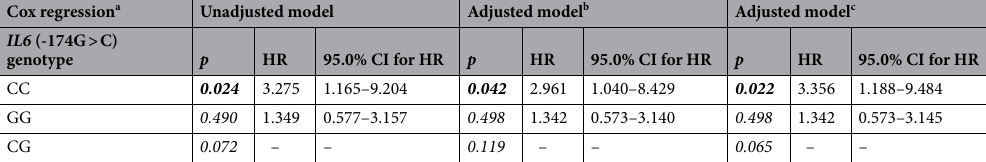
Table 8. Cox regression analysis according to the IL6 (rs1800795) polymorphism for all-cause mortality in end-stage renal disease patients ( n = 268). a Cox regression analysis using as reference the heterozygous genotype patients. b Adjusted for age, dialysis vintage and vascular access. c Adjusted for age, dialysis vintage, vascular access, and the co-morbidities, diabetes mellitus and history of cardiovascular disease. CI confidence interval, HR hazard ratio, IL6 interleukin 6. Italic denotes p -values and bold-italic statistically significant p